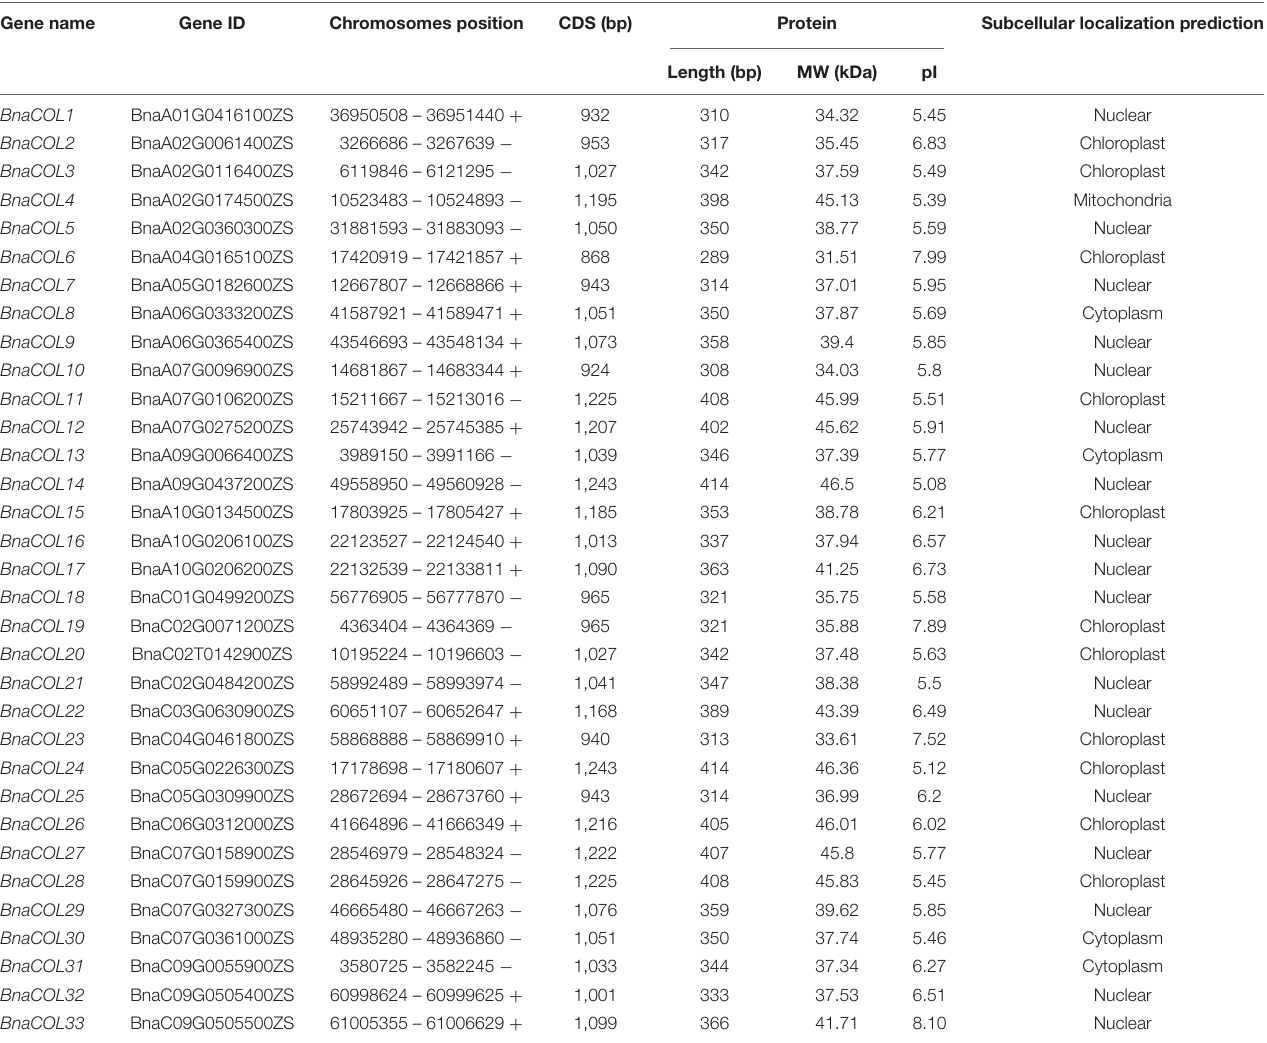
TABLE 1 | The position and molecular information of COL gene family in B. napus